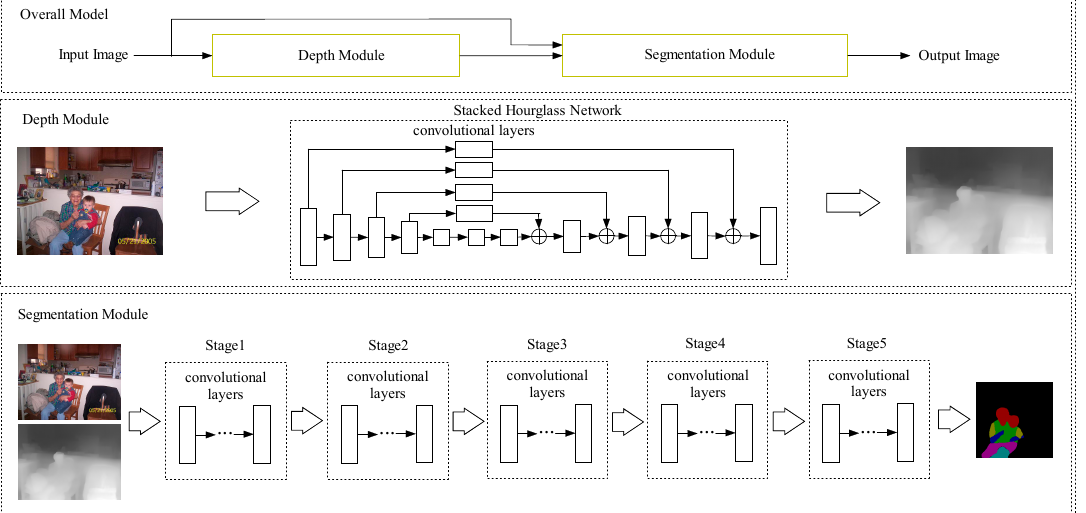
Figure 1. The proposed model for human parsing. The Overall Model (OM) is composed of a Depth Module (DM) and a Segmentation Module (SM). The DM is based on the hourglass network proposed in [25] and is trained on the MegaDepth Dataset proposed in [24]. The trained DM is used to pre-process the training and test images. The training data includes the Pascal Person Part Dataset [7] and the LIP Dataset [26]. The SM is composed of five stages of convolutional layers.